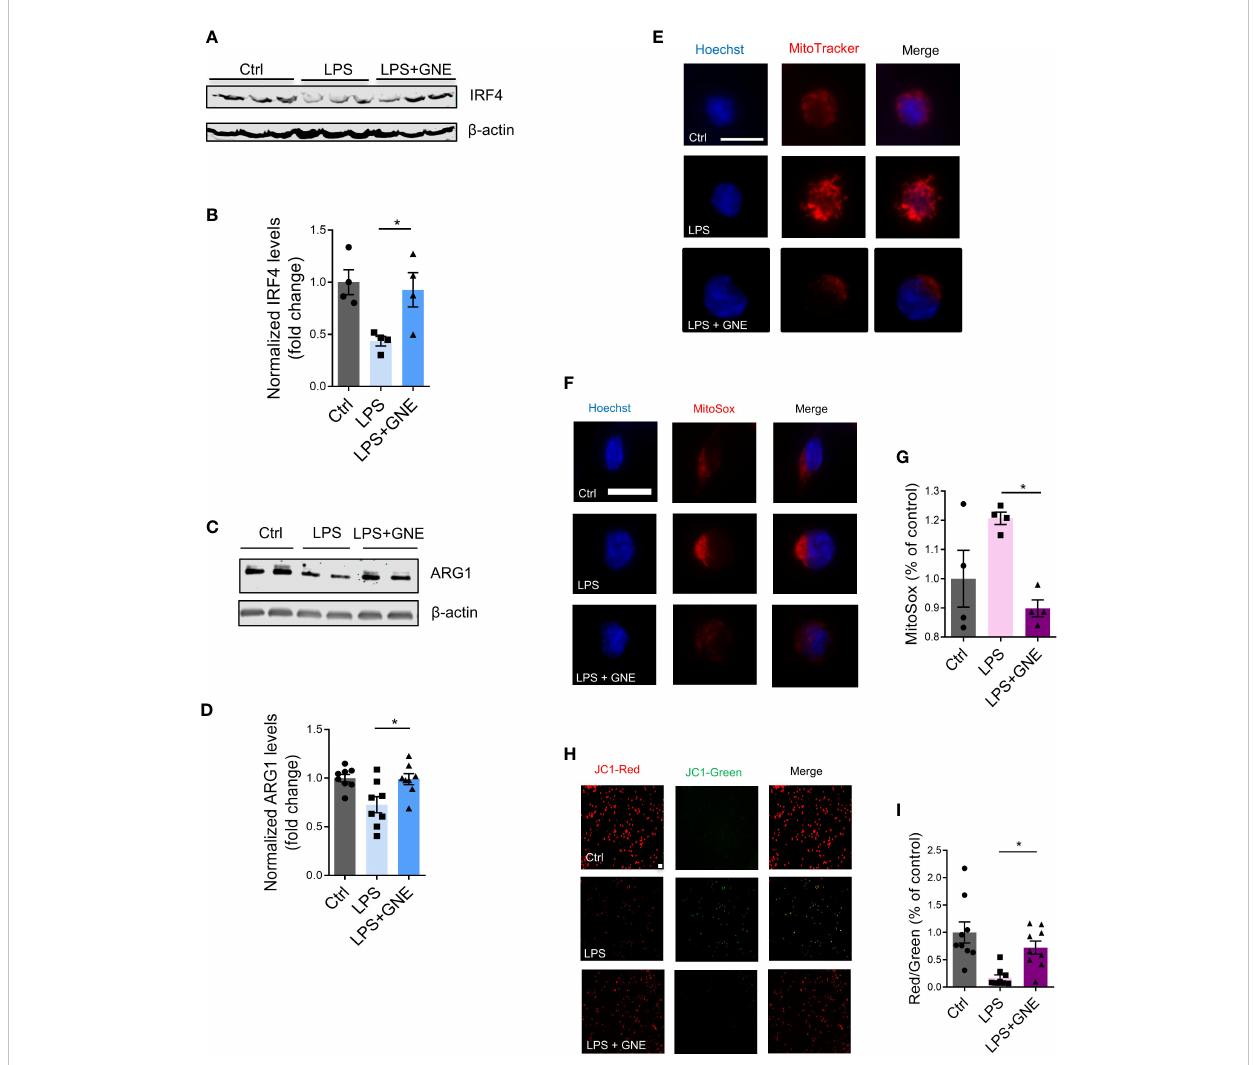
FIGURE 4 GNE-049 increases the expression of the M2 polarization marks IRF4 and ARG1. Representative Western blots and densitometry assessing (A, B) IRF4 (n=4) and (C, D) ARG1 (n=8) in MMCs. (E) MitoTracker probe staining shows changes in mitochondrial morphology in MMCs cotreated with GNE- 049 (n=3). Scale bar, 10 µm. (F, G) MitoSOX assays reveal that GNE-049 reduced LPS-induced superoxide generation by inhibiting H3K27ac deposition (n=4). Scale bar, 10 µm. (H) JC1 probe (scale bar, 50 µm) and (I) quantitative analysis of Dy m by the ratio of red and green fl uorescence. Data show mean±SEM of one-way ANOVA followed by Tukey ’ s post hoc test. Ctrl, control; *p ≤